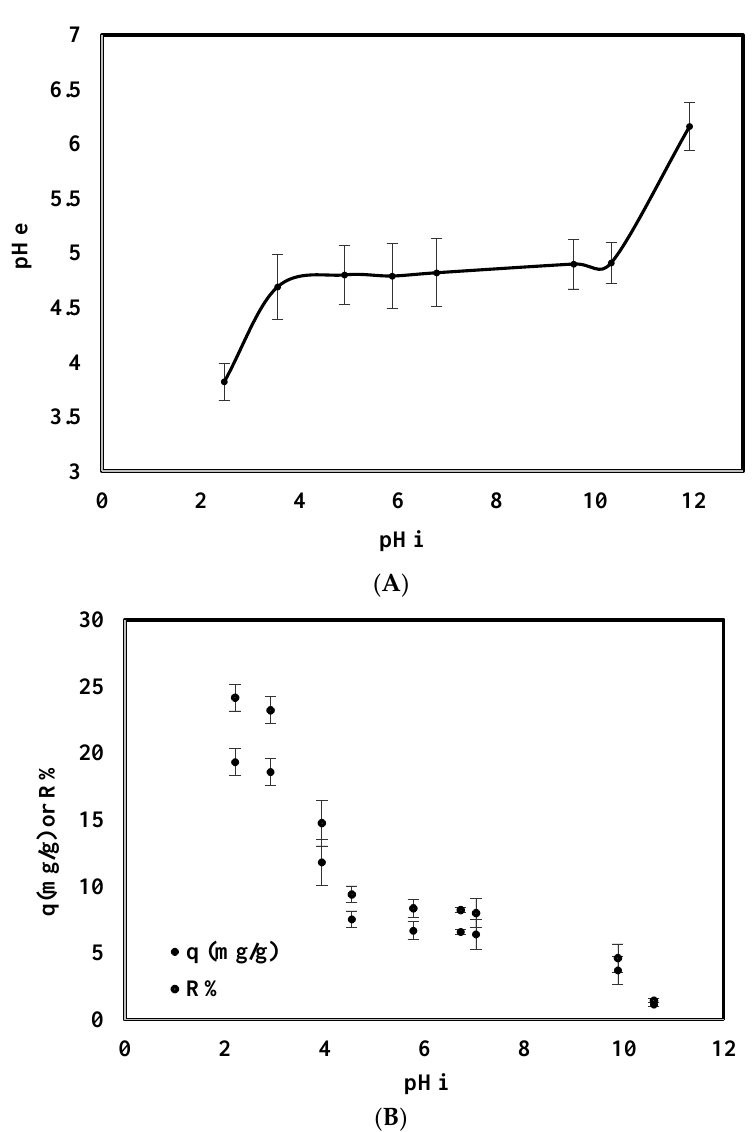
Figure 7. ( A ) Effect of pHi on pHe for a 20 mL solution of 0.1 M NaCl containing 0.01 g of FeNP; and ( B ) effect of solution pH on adsorption capacity (q) and removal efficiency (R).